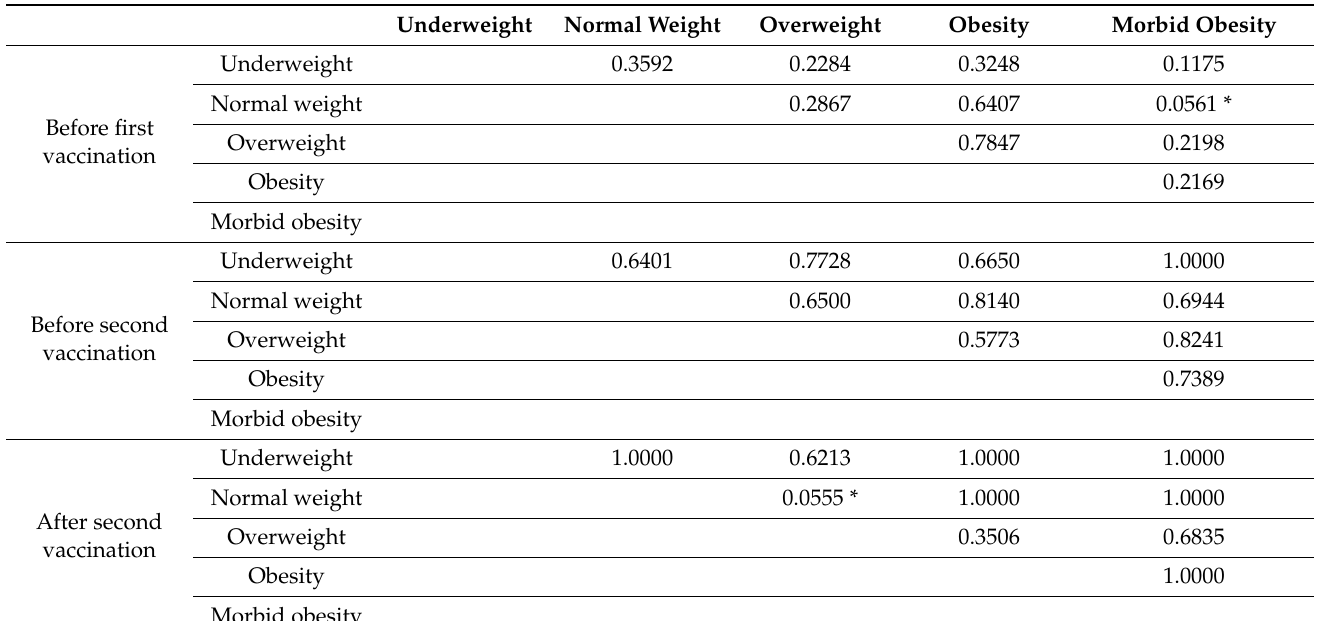
Table 2. Two-sided p -values for difference in COVID-19 positivity between body mass index (BMI) groups. * Significant if one-sided test was assumed.